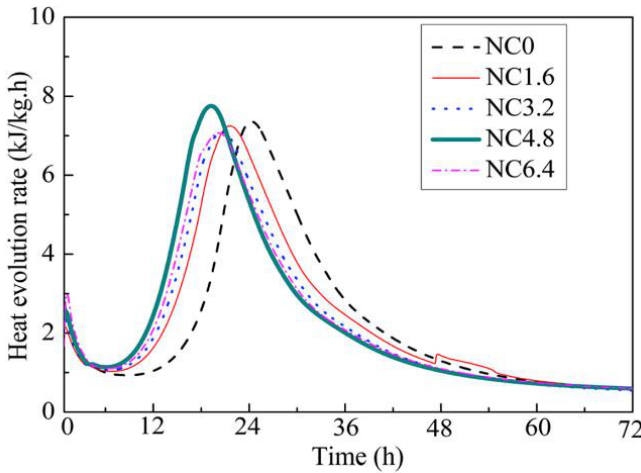
Figure 8. Effects of nano-calcium carbonate contents on heat evolution rate of ultra-high strength concrete (UHSC) [77].